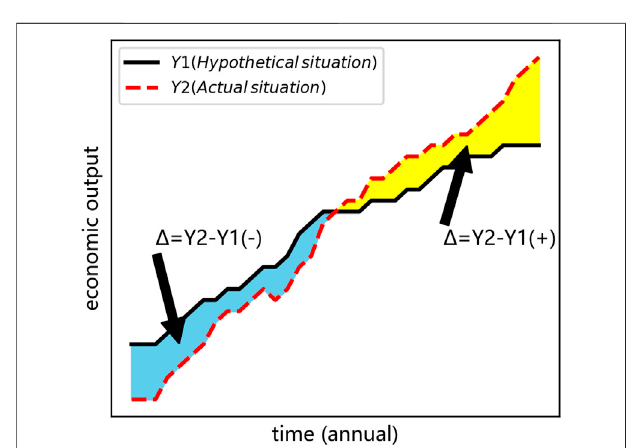
FIGURE2| Schematicdiagram oftheyieldimpactofclimatechange. Y 1 is the economic growth state (idealized state) when the climate does not change,and Y 2 istheactualstateoffutureeconomicgrowth. Δ representsthe impact of climate change on economic output, that is, the difference between Y 2 and Y 1 .( − ) indicates thattheimpactofclimatechangeisnegative, (+) indicates that the impact of climate change is